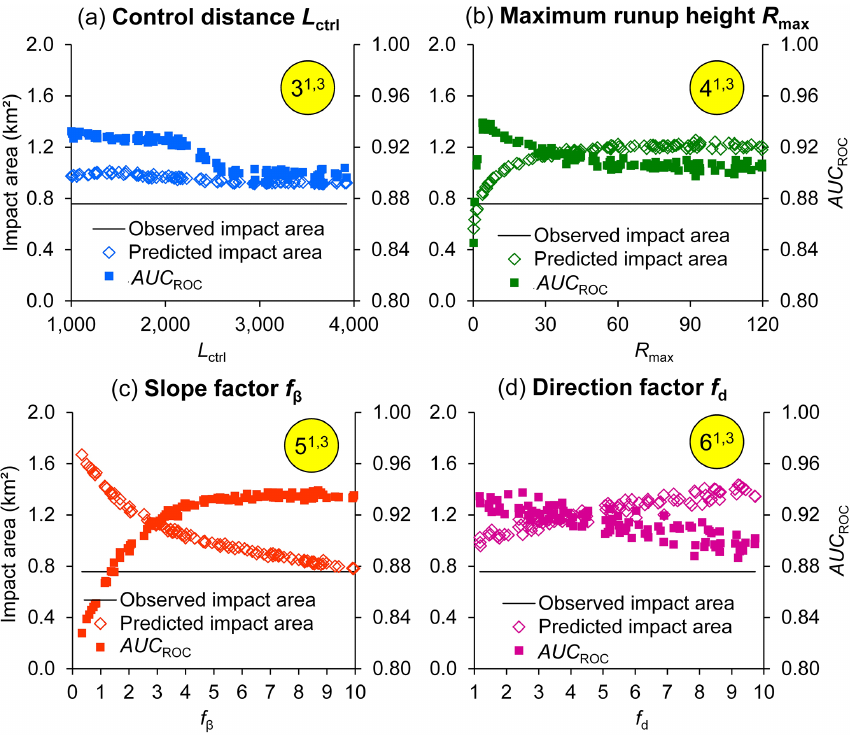
Figure 7. Sensitivity of impact area and AUC ROC to selected input parameters. The numbers of the corresponding tests (see Table 4) are indicated in the yellow circles. (a) Control distance L ctrl ; (b) maximum run-up height R max ; (c) slope factor f β ; (d) direction factor f d